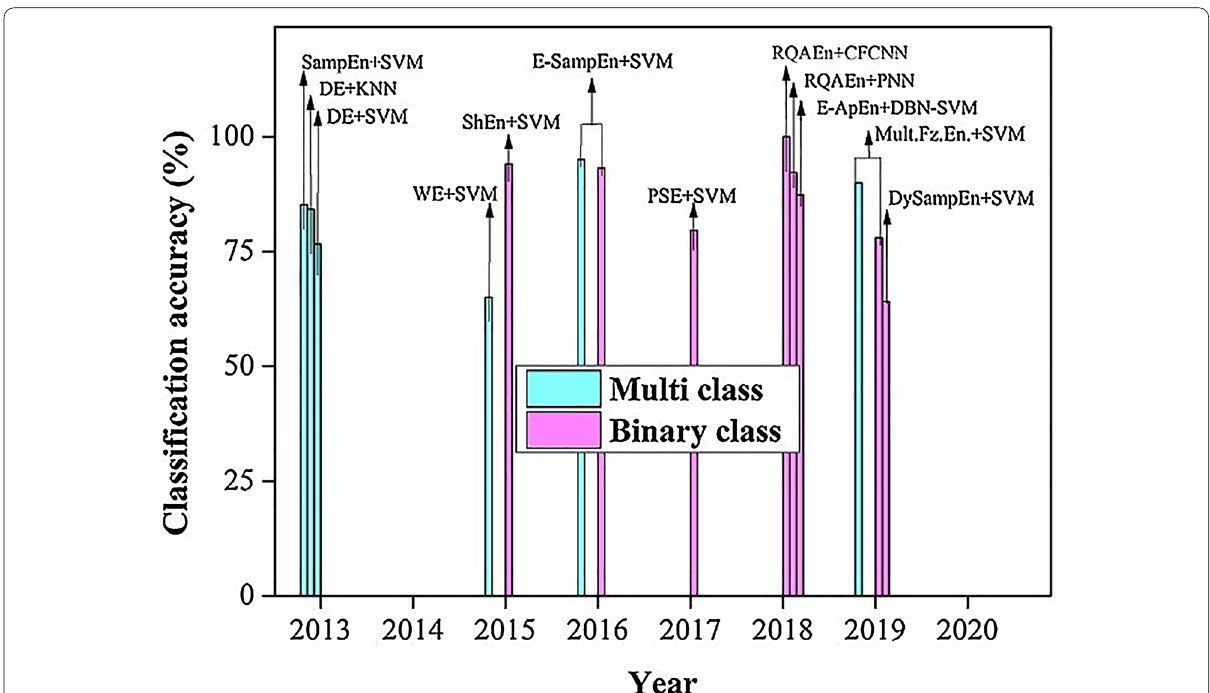
Fig. 3 Classification accuracy of different methods with their publication